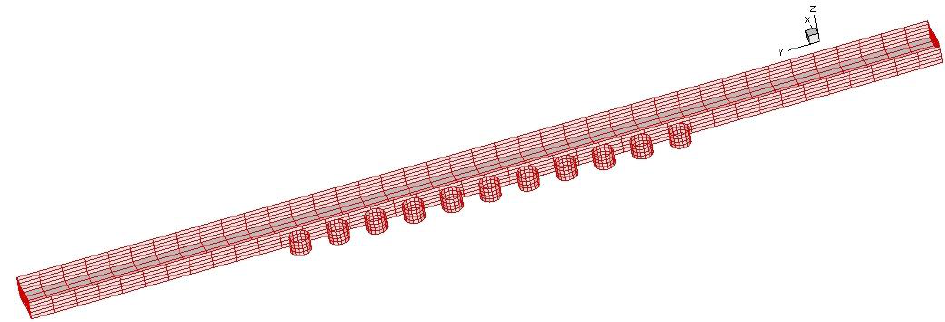
Figure 4. 3D mesh of the calculation model for the parametric study. ( T / h = 0.25, D / h = 12, B / h = 0.6, s 1 / h = 0.5, s 2 / h = 0.2)